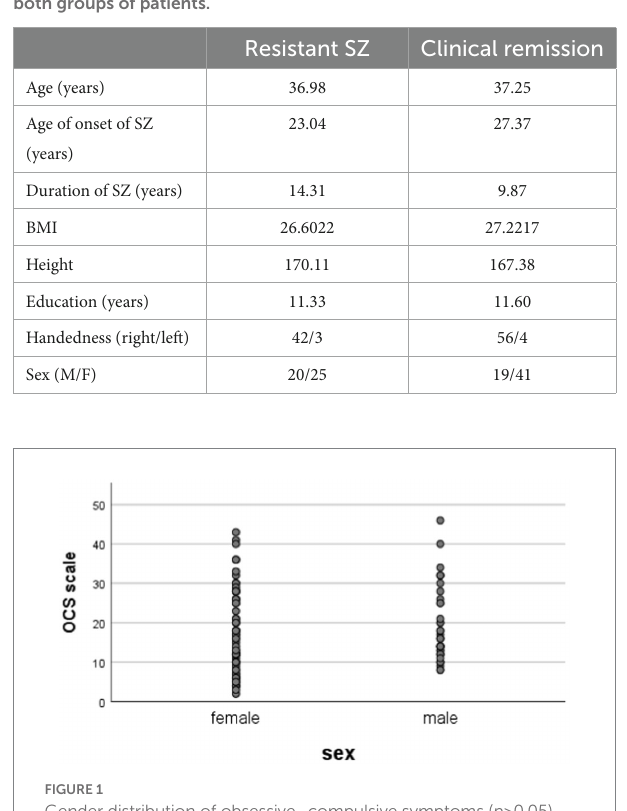
TABLE 1 Distribution of patients’ age, age of onset of schizophrenia, duration of schizophrenia, BMI, height, education, and handedness in both groups of patients.